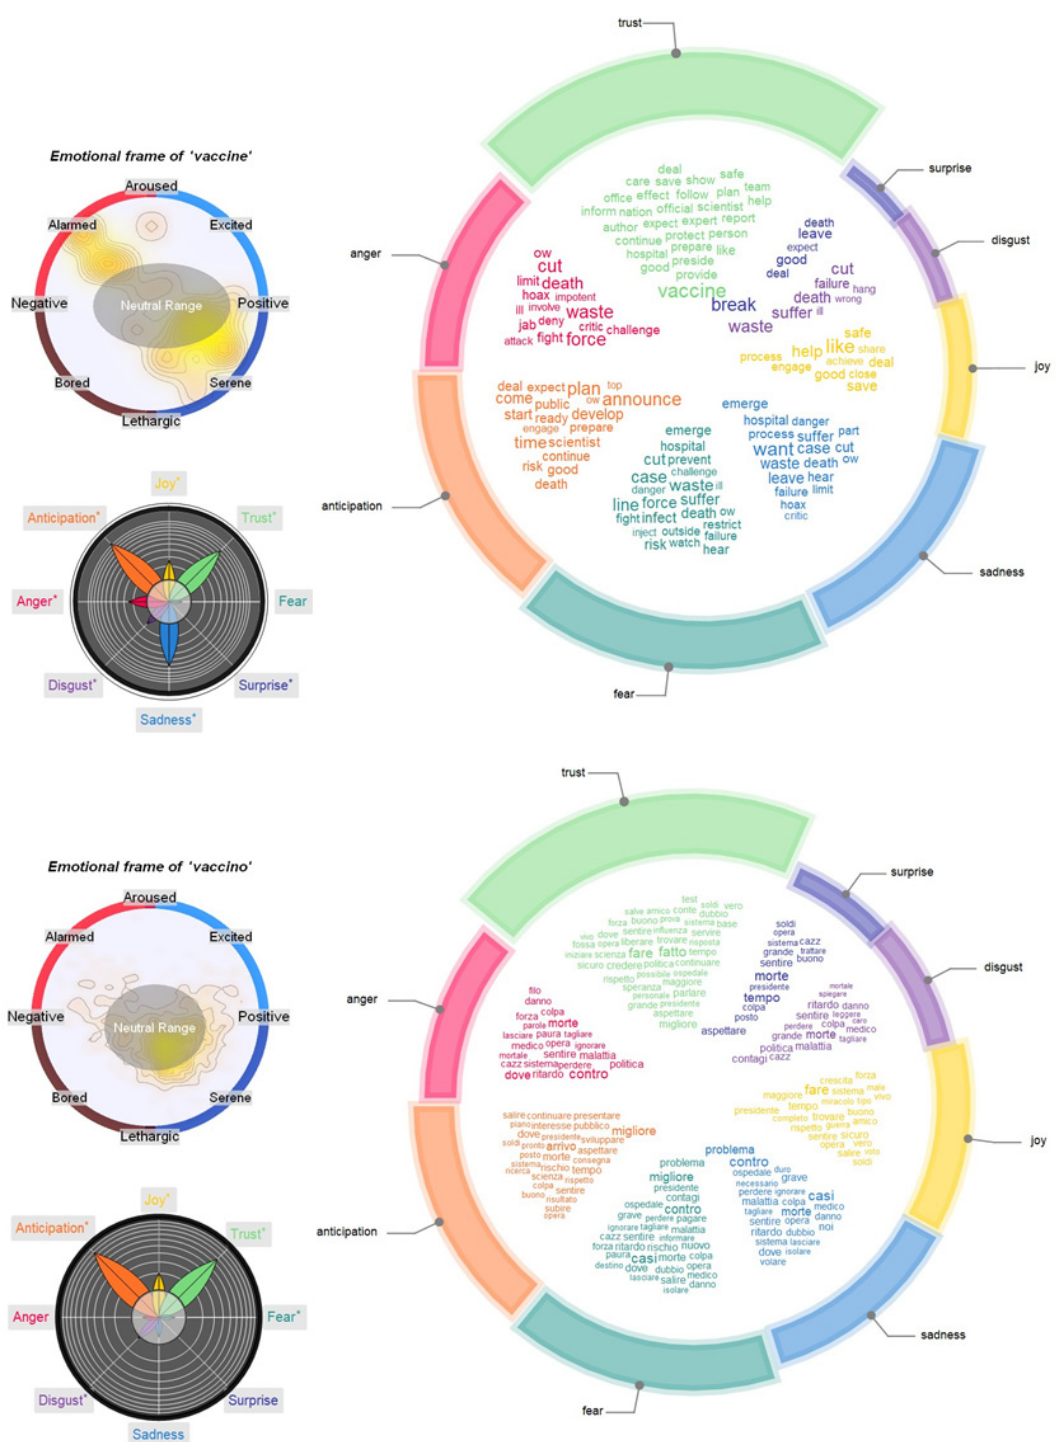
Figure 3. Emotional analysis and word clouds of concepts in the semantic frame of “vaccine” (in English) and “vaccino” (in Italian). The circumplex model indicates how the neighbours of vaccine/vaccino populate a 2D arousal/valence space. The emotion flower indicates an excess of emotions detected in the semantic frame compared to random expectation. The sector chart reports the raw fraction of words eliciting a certain emotion. The word cloud reports the top 10% concepts with the highest degree of centrality which are associated with vaccine. The words are distributed according to the emotions they elicit. Asterisks highlight emotions z > 1.96.